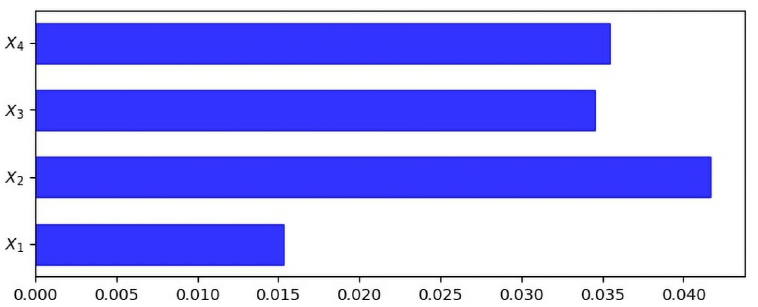
Fig 4. SHAP values to estimate variables’ prediction contributions. Note. X 1 = performance; X 2 = expectations; X 3 = disconfirmation; X 4 =